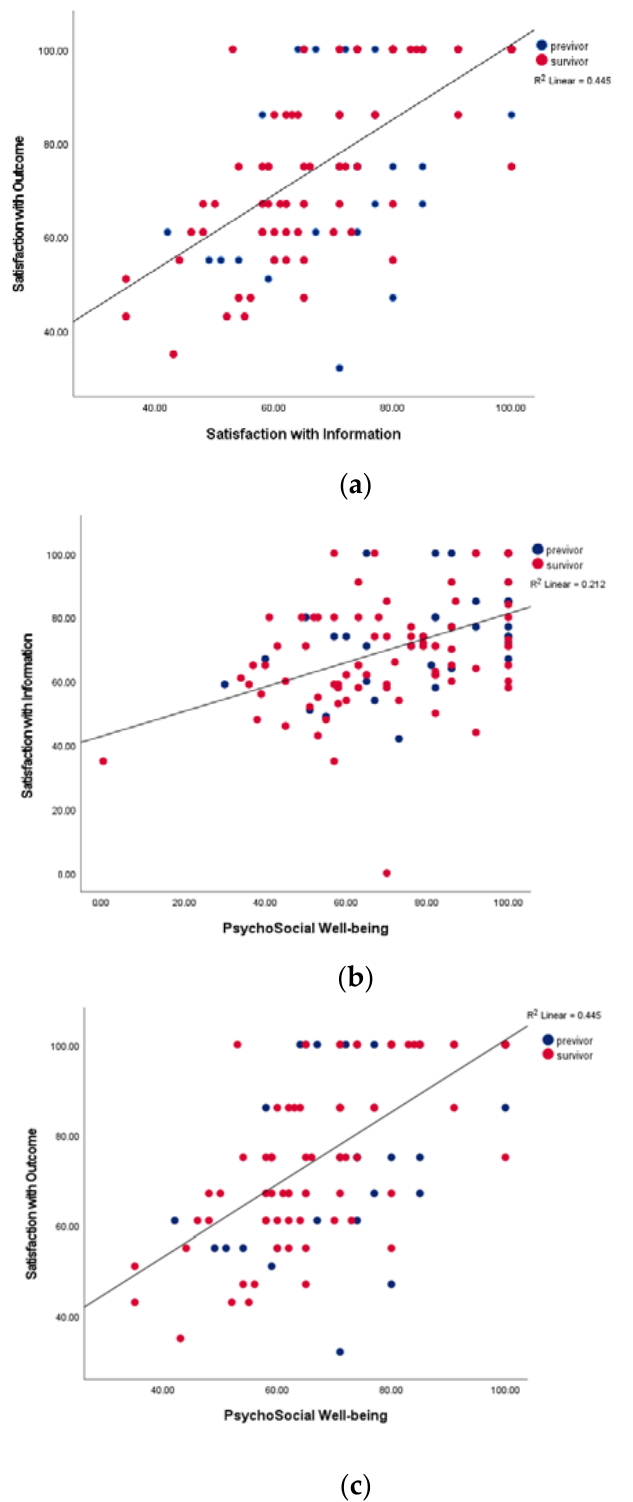
Figure 2. Highly significant correlation of psychological well-being, satisfaction with information, and satisfaction with outcome among all participants: previvors (blue) and survivors (red). ( a ) Satisfaction with outcome and satisfaction with information p = 0.000. ( b ) Psychosocial well-being and satisfaction with information, p = 0.000. ( c ) Satisfaction with outcome and psychosocial well-being, p =